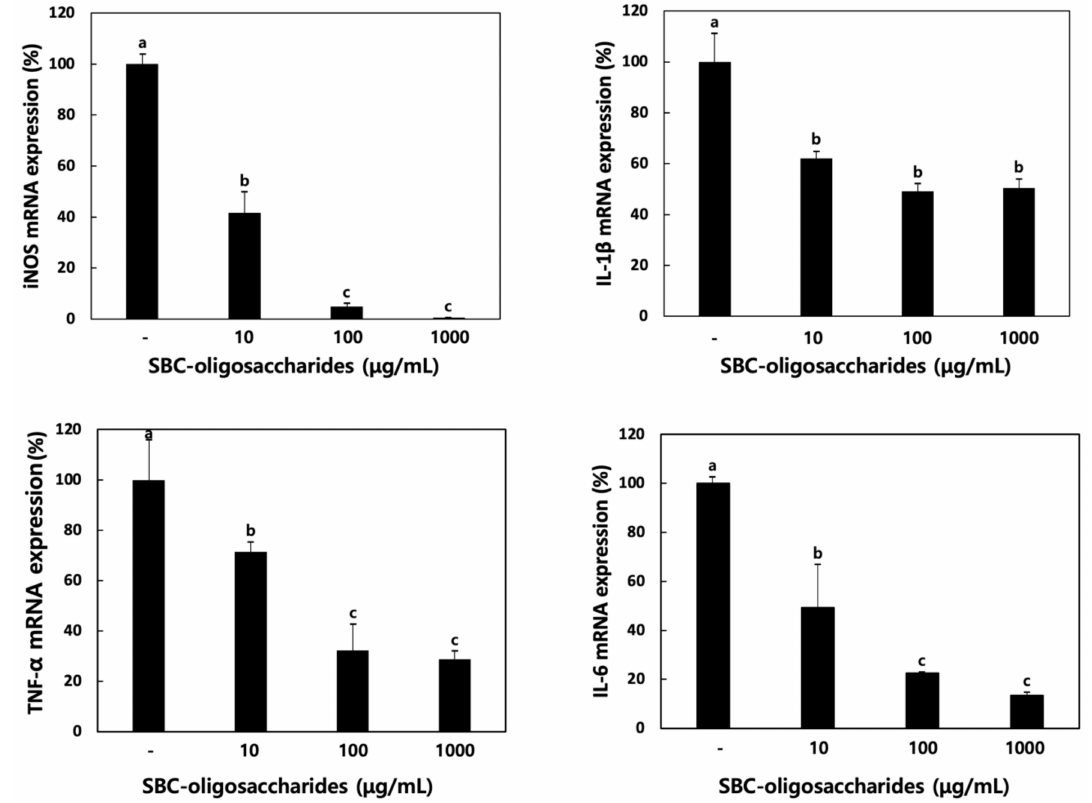
Figure 7. Relative mRNA expression of inducible NO synthase (iNOS) and inflammatory cytokines upon treatment with oligosaccharides in RAW 264.7 cells. RAW 264.7 cells were pretreated with oligosaccharides for 1 h and then stimulated with 1 µ g/mL LPS. One-way ANOVA was used to compare group mean values, followed by Duncan’s t -test. Different letters represent significant differences among groups at p < 0.05 (n ≥